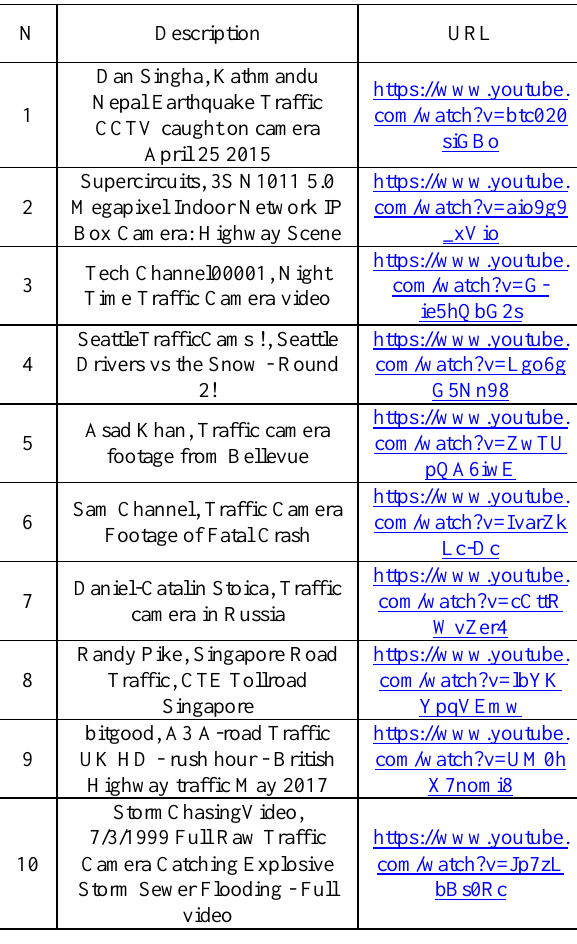
Table 1. Traffic cameras videos used to test ANN & MD